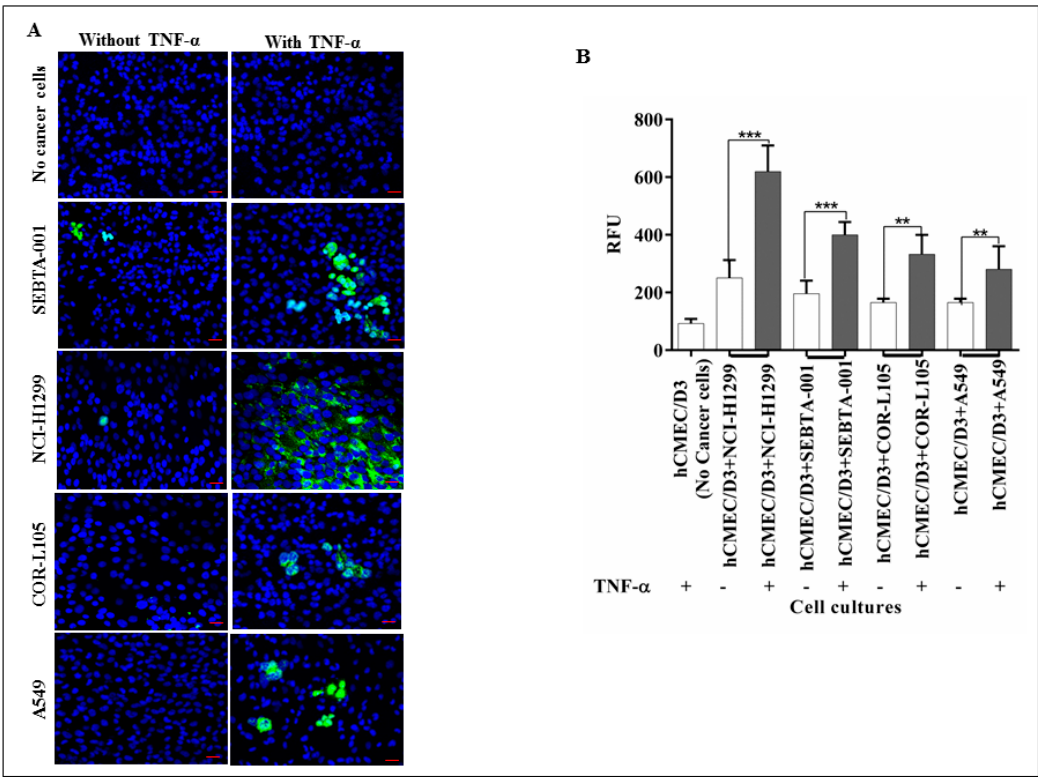
Figure 2. The role of CD62E in adhesion of NSCLC cells to brain endothelium: ( A ) Qualitative adhesion of NSCLC cells onto brain endothelium monolayer. Green fluorescently tagged NSCLC cells were applied onto the hCMEC/D3 monolayer and incubated for 90 min with and without activation via TNF- α . Non-adherent cells were washed and co-cultures were fixed and examined by confocal microscopy; ( B ) quantitative adhesion of NSCLC cells. hCMEC/D3 cells were seeded into 96-well plate followed by seeding of green fluorescently tagged NSCLC cells on the hCMEC/D3 monolayer and incubated for 90 min incubation. Non-adherent cells were washed out and adherent cells were lysed followed by quantification via a microplate reader at 480–520 nm. Results showed a strong decrease in adhesion caused by absence of TNF- α (White bar) compared to TNF- α stimuli. n = 3, *** p < 0.001 and ** p < 0.01. Scale bar = 20 µm. Data is expressed as ±SE.